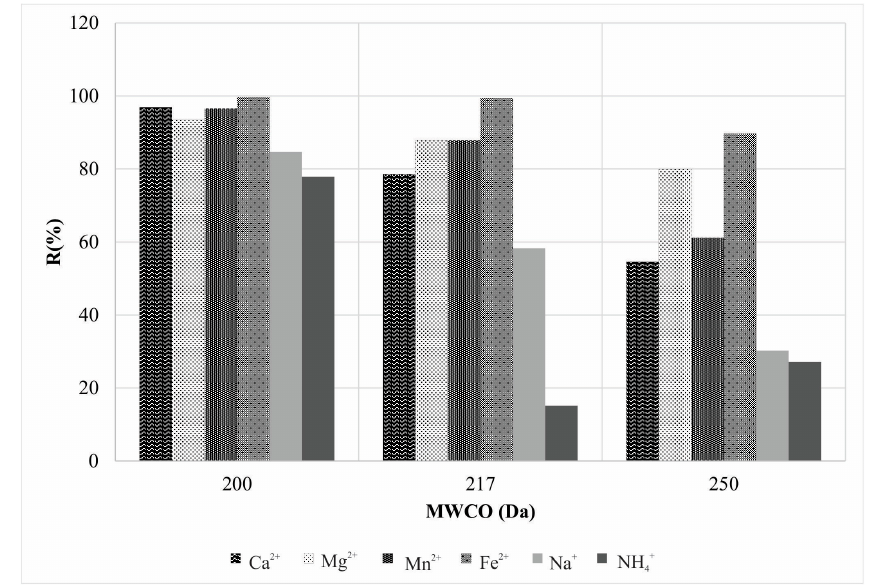
Figure 4. Cation rejection distribution at different filtration